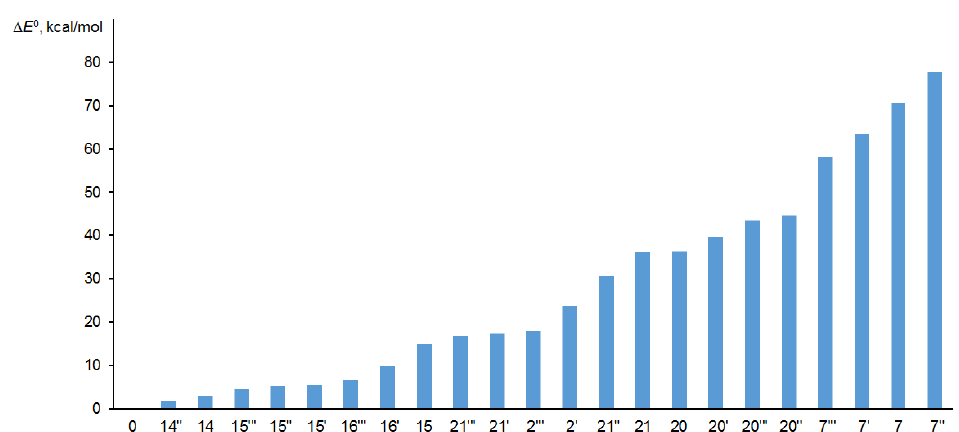
Figure 7. Difference of the absolute energies Δ E 0 (kcal/mol) of the main diastereomers of alasmon- tamine A, as compared to the original configuration.